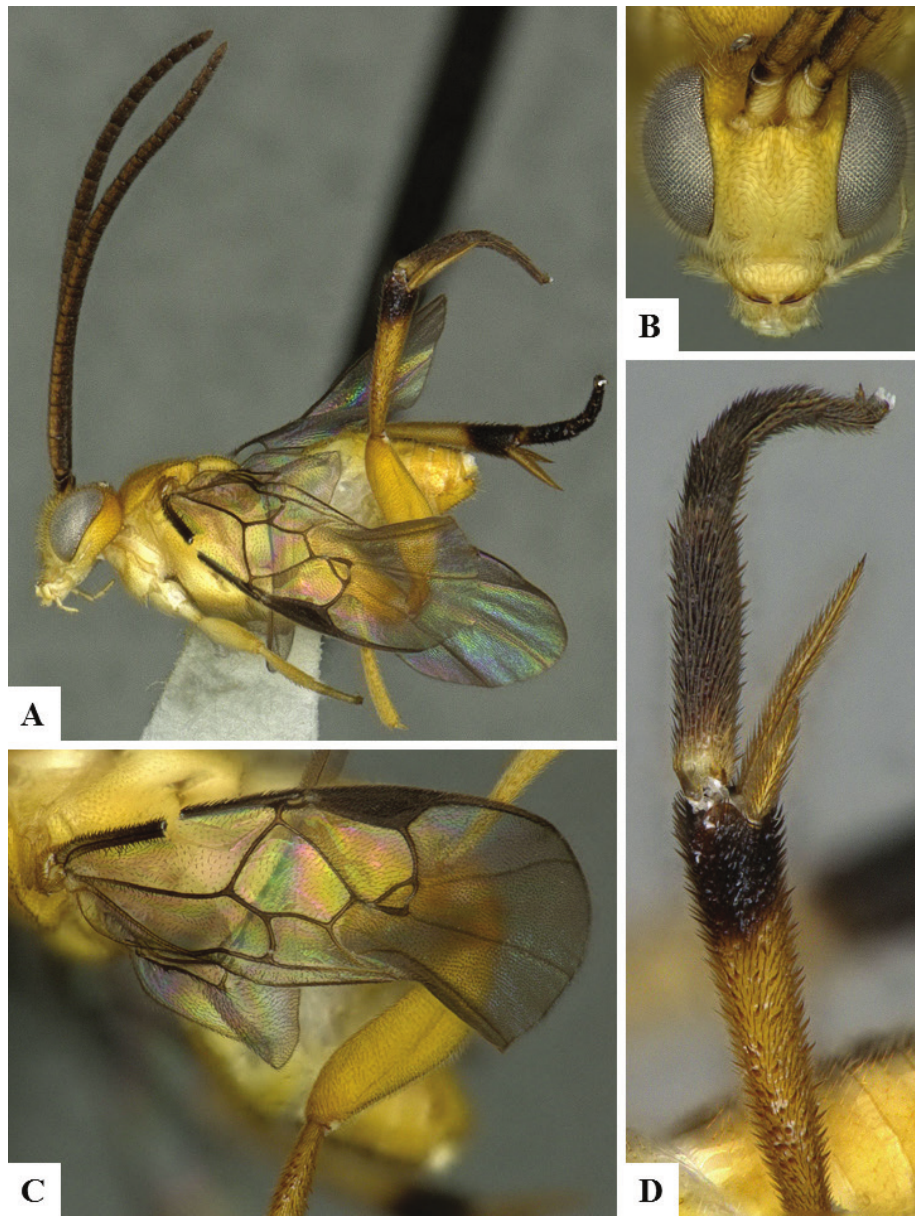
Figure 24. Jimwhitfieldius jamesi female paratype CNC878555. A Habitus B Head frontal C Fore wing D Inner and outer spines of